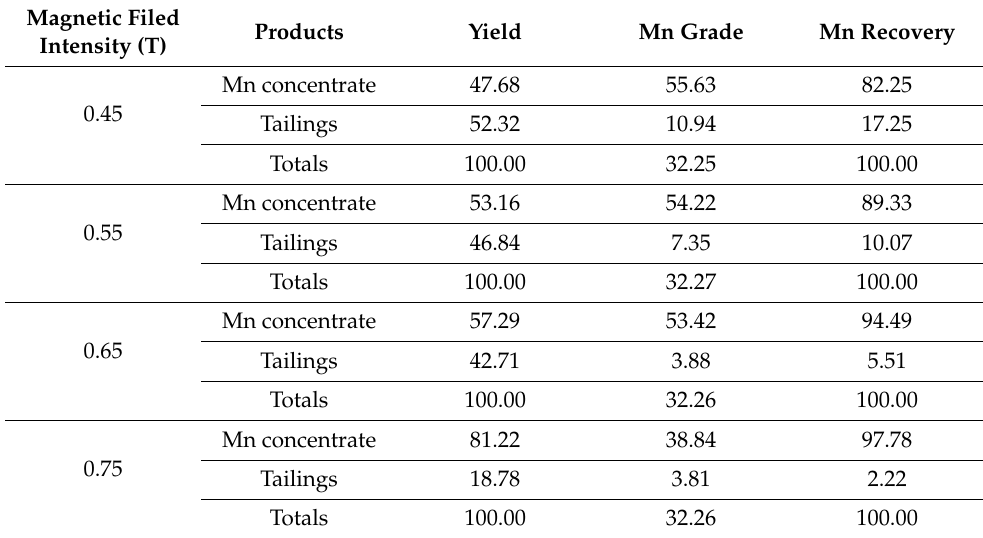
Table 4. Manganese extraction results from the low-intensity magnetic separation tailings (%).